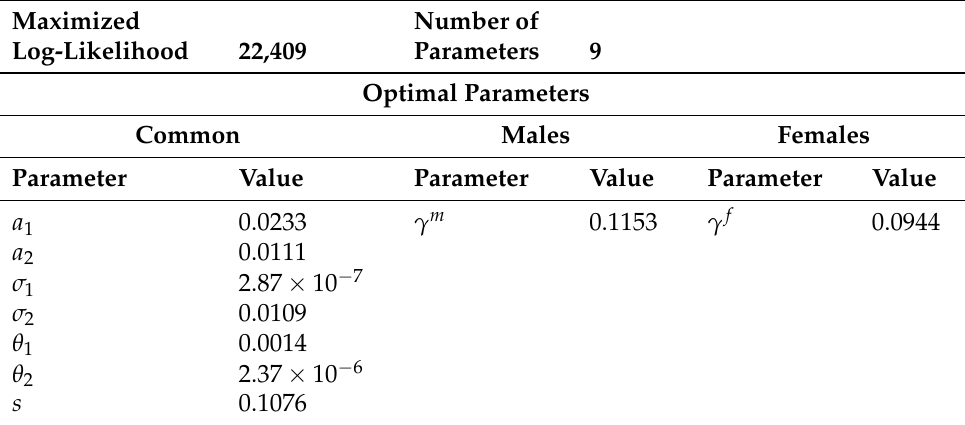
Table 1. This table collects the optimal parameters for our model. For each population, the “common” column collects the parameters relative to the factor processes and the measurement variance– covariance matrix s . The other two columns collect the parameters relative to the response functions of the two populations of males and